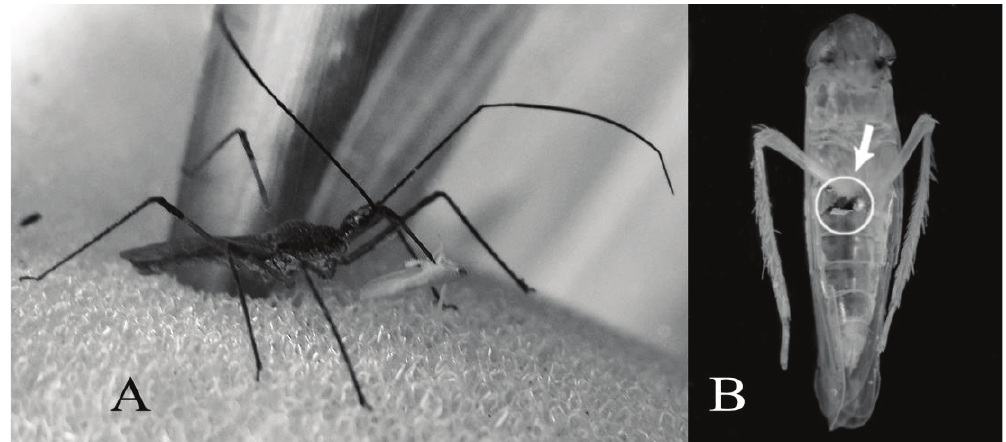
Figure 1. ( A ) Zelus obscuridorsis (Stål) preying an adult of Dalbulus maidis (DeLong and Wolcott); ( B ) corn leafhopper ’ s empty exoskeleton; the arrow indicates the area of insertion of the